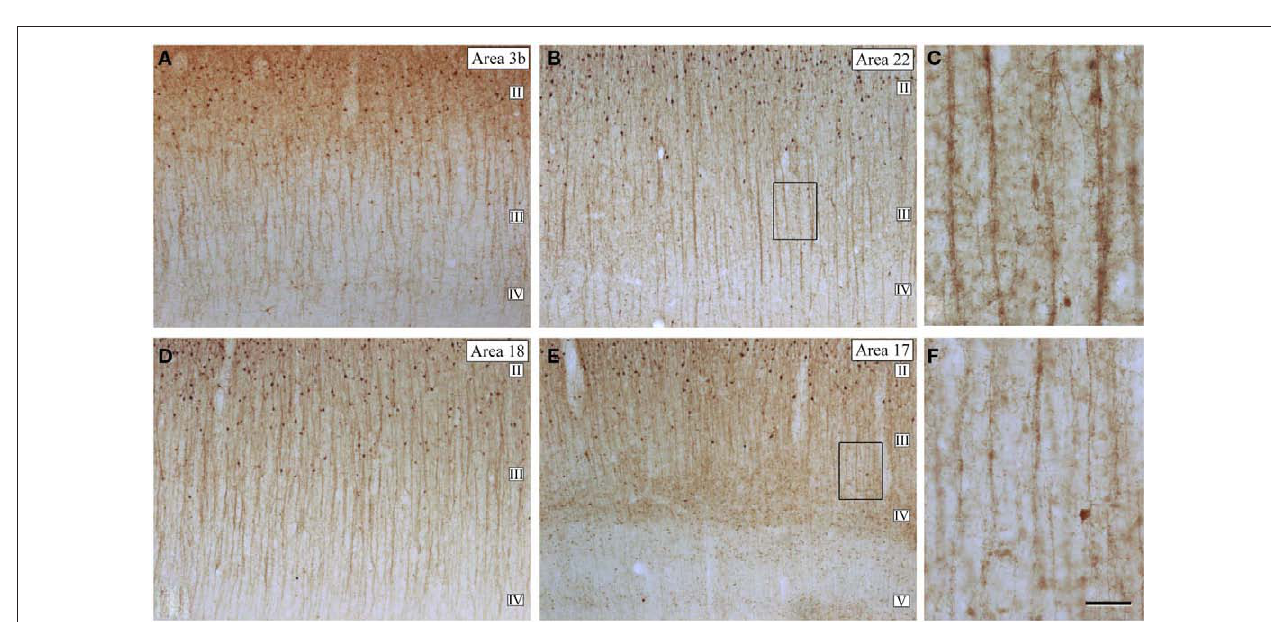
number and the regular distribution of double bouquet cell horse-tails. (C,F) High magnification of the boxed areas shown in (B,e) , respectively, to highlight the differences in thickness, density, and number of axon collaterals of CB-ir double bouquet cell horse-tails in different cortical areas. Scale bar: 150 μm in (A,B,D,e) ; 45 μm in (C–F) . Adapted from Ballesteros-Yánez et al.